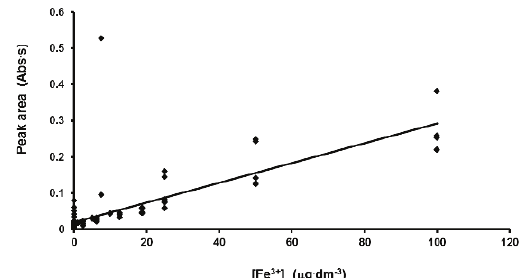
Regression lines for determination of iron by Zeeman GFAAS. All calibration data over several days pooled and depicted in one single diagram without removing